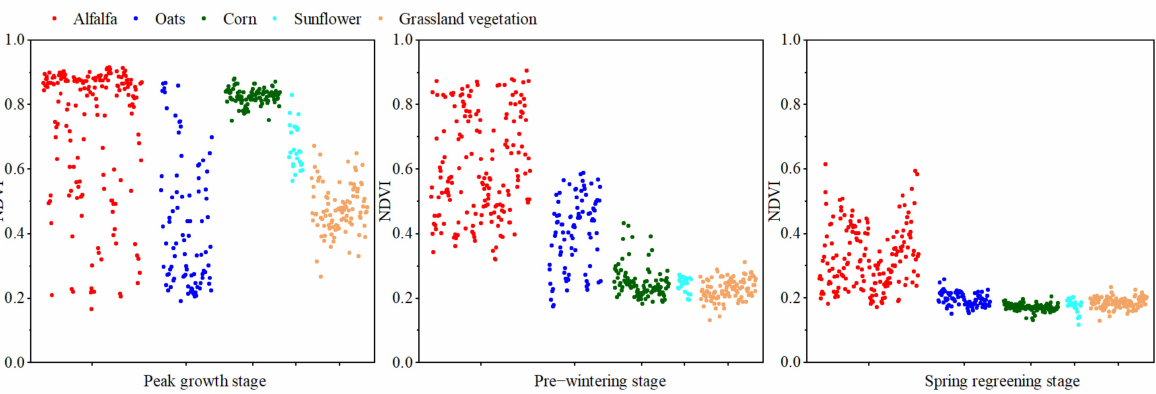
Figure 6. NDVI values of different vegetation types derived from the Sentinel-2 data at the different growth